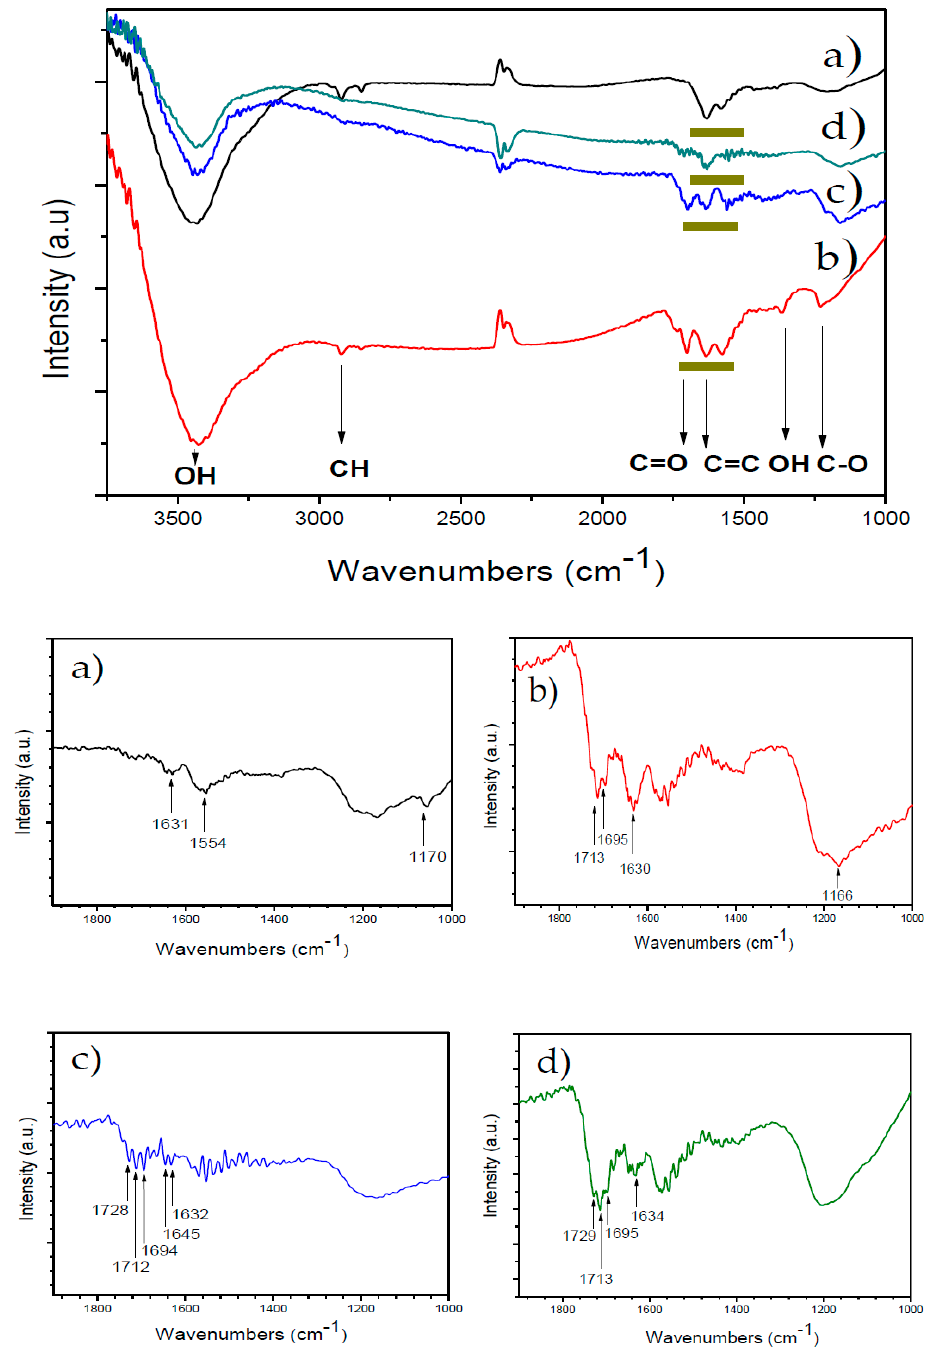
Figure 1. FTIR of oxidized and functionalized multiwalled carbon nanotubes (MWCNTs): ( a ) MWCNT, ( b ) MWCNT-Ox, ( c ) MWCNT-IA, and ( d ) MWCNT-MMI. The zones marked in dark yellow represent each MWCNT additive.